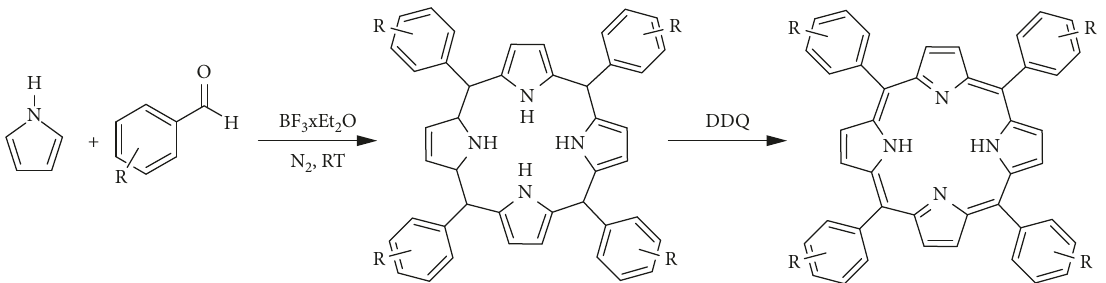
Figure 14: Schematic method as by Linsdey in 1987